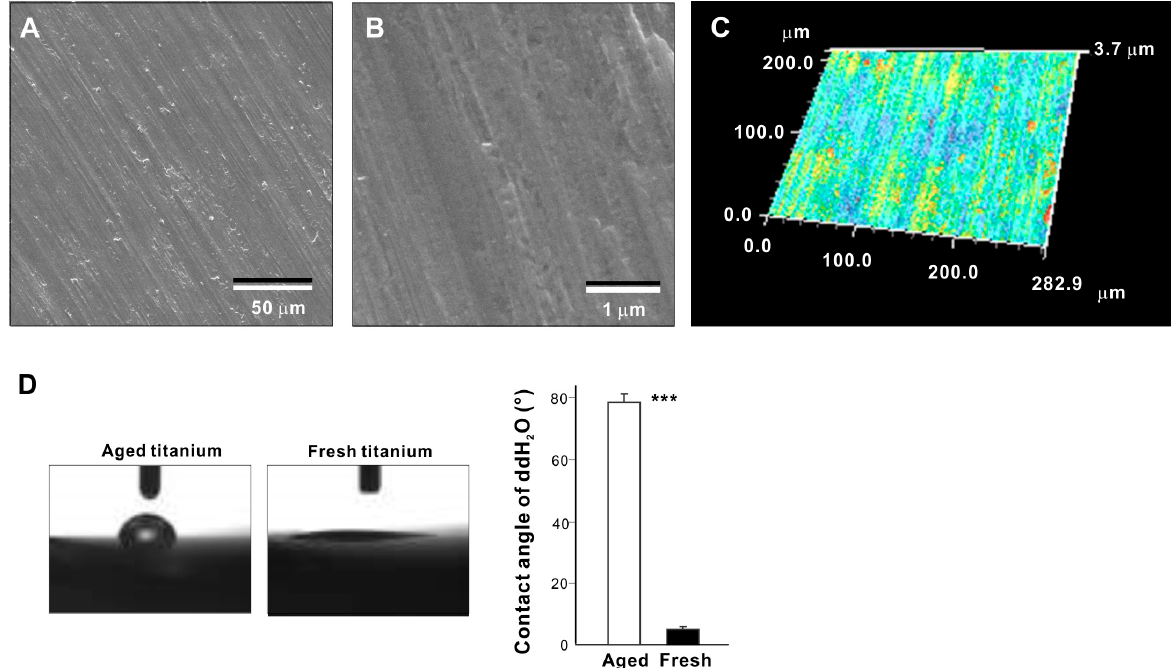
Figure 1. Surface characterization of titanium disks used in this study. Low ( A ) and high ( B ) magnifi- cation SEM images of the titanium disks. ( C ) 3-dimensional imaging of the titanium disks obtained with an optical profilometer. ( D ) Side-view photographs of a 1 µ L drop of ddH 2 O placed on a tita- nium disk and a histogram showing contact angle measurements. Fresh (newly prepared) titanium and aged (stored for 1 month) titanium disks were compared. *** p < 0.001, statistically significant difference between fresh and aged titanium